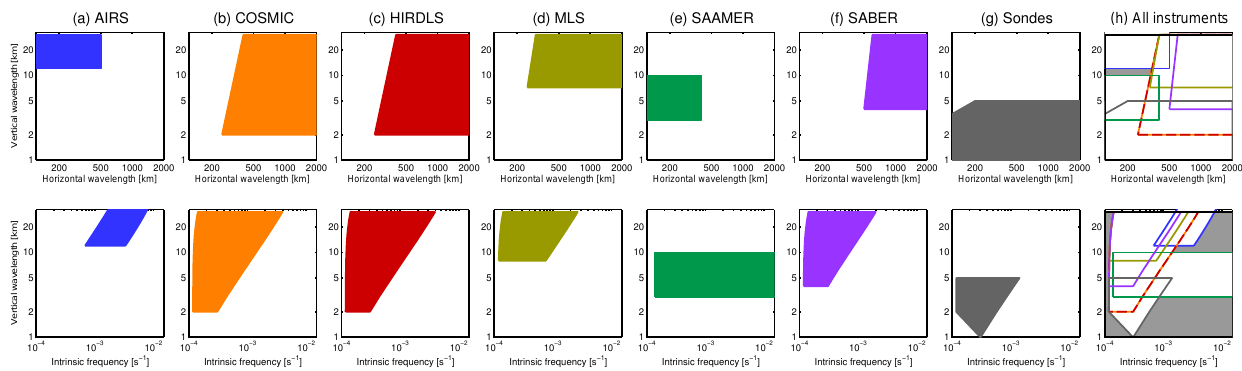
Figure 9. Approximate observational filters for the instruments considered, in terms of observable horizontal and vertical wavelengths (top row) and observable intrinsic frequencies and vertical wavelengths (bottom row). Based upon Alexander et al. (2010) and Preusse et al.